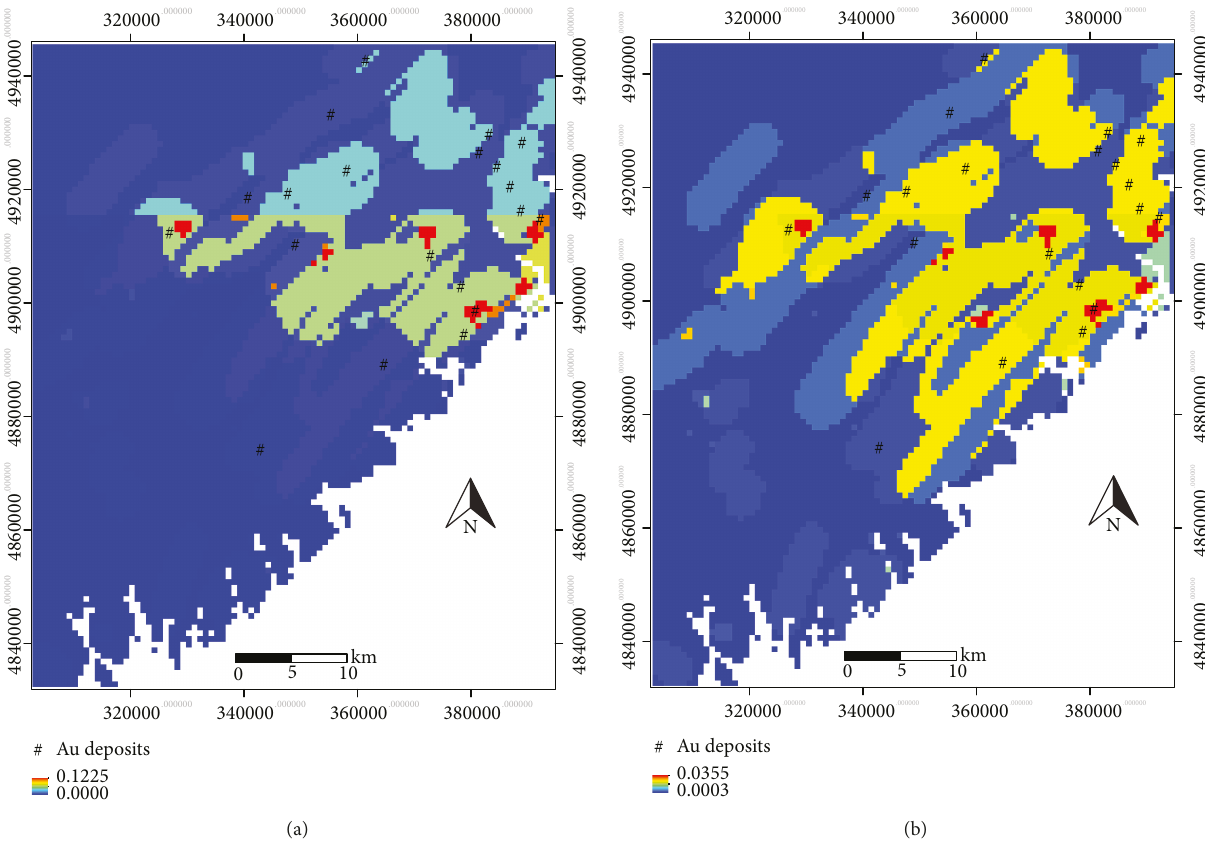
Figure 8: Posterior probability maps obtained by (a) weights of evidence and (b) modi fi ed weights of evidence in experiment 5.